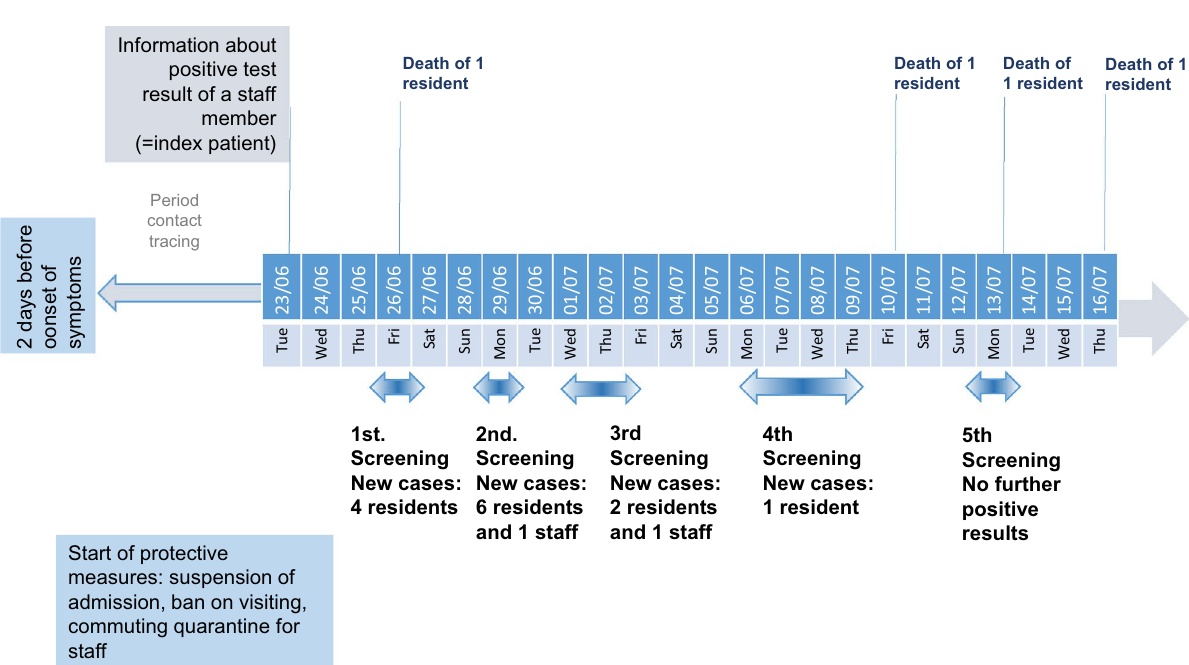
Figure 3. Timeline of events and directed measures in nursing home NH03. Graphical representation of the chronological sequence of screenings, new infections, deaths and measures taken to contain the